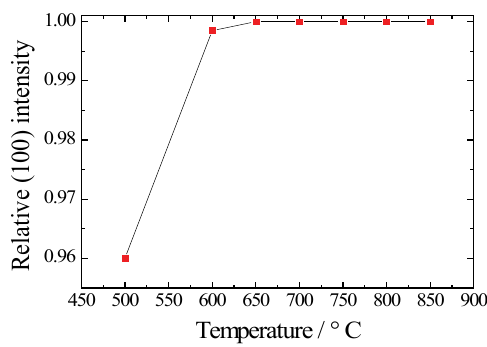
Figure 4. Relative (100) intensities of annealed E-Cu57 substrates.